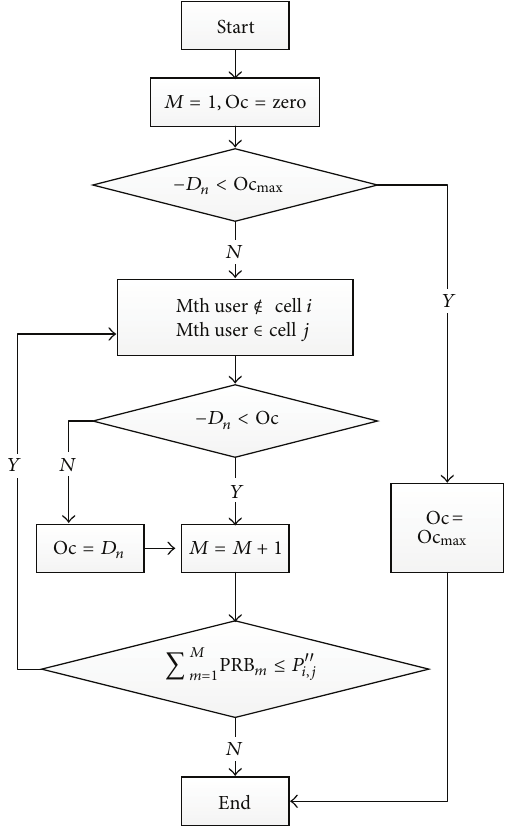
Figure 9: The load balancing flow chart.